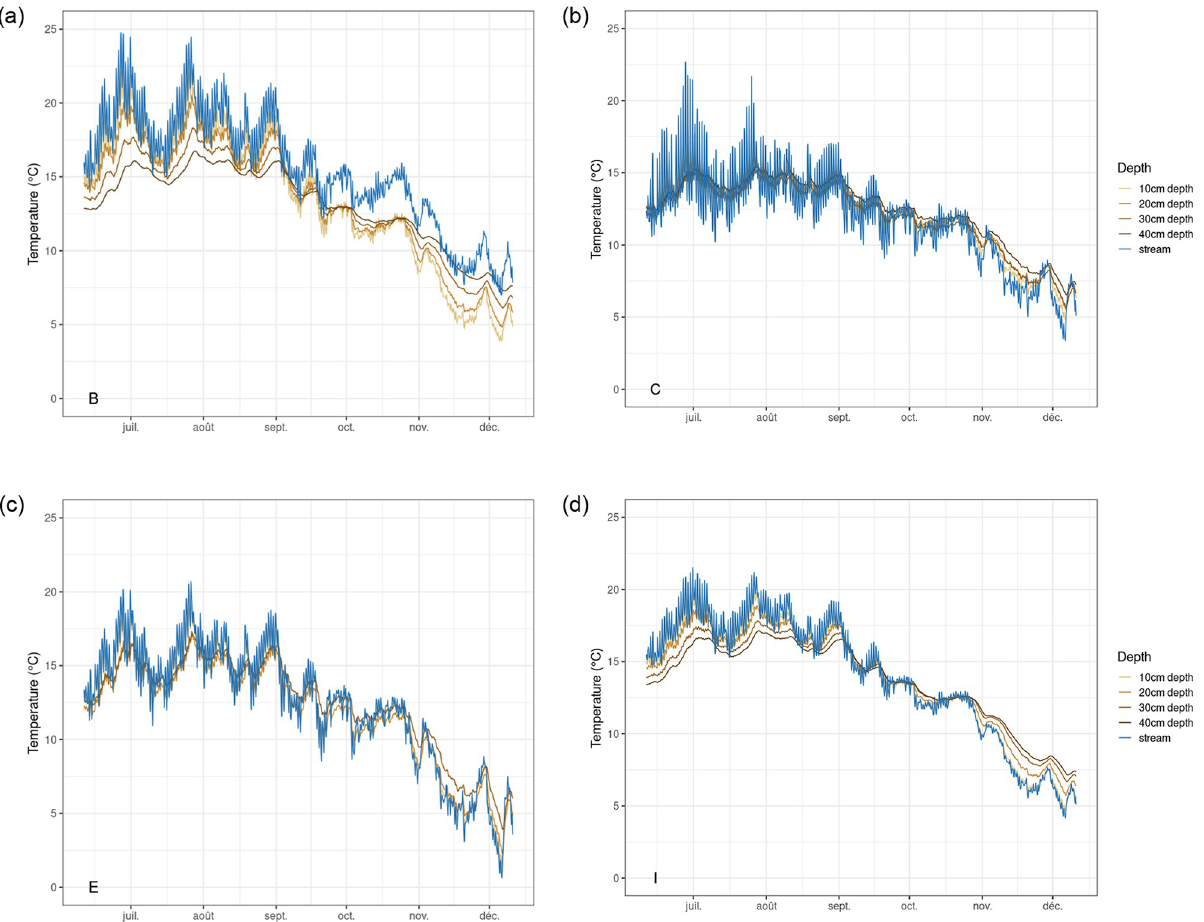
Fig 4. Temperature time series in the stream and adjacent hyporheos. Upper-left quadrant: B station. Upper-right quadrant: C station. Lower-left quadrant: E station. Lower-right quadrant: I station. Blue line: stream temperature. Brown lines: hyporheos temperature at increasing depths, from 10cm-deep (pale brown) to 20cm-, 30cm- and 40cm-deep (dark brown).